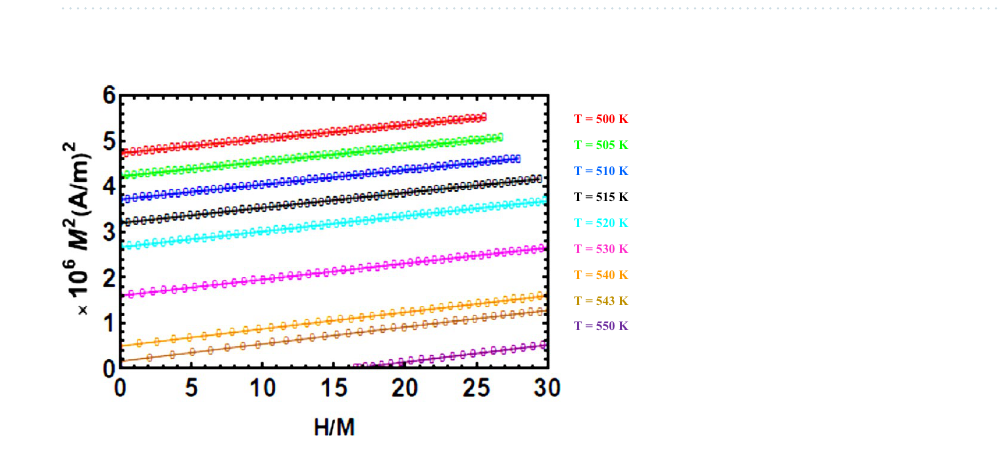
Figure 14. The Arrott plots, at different temperatures, for YFe 3